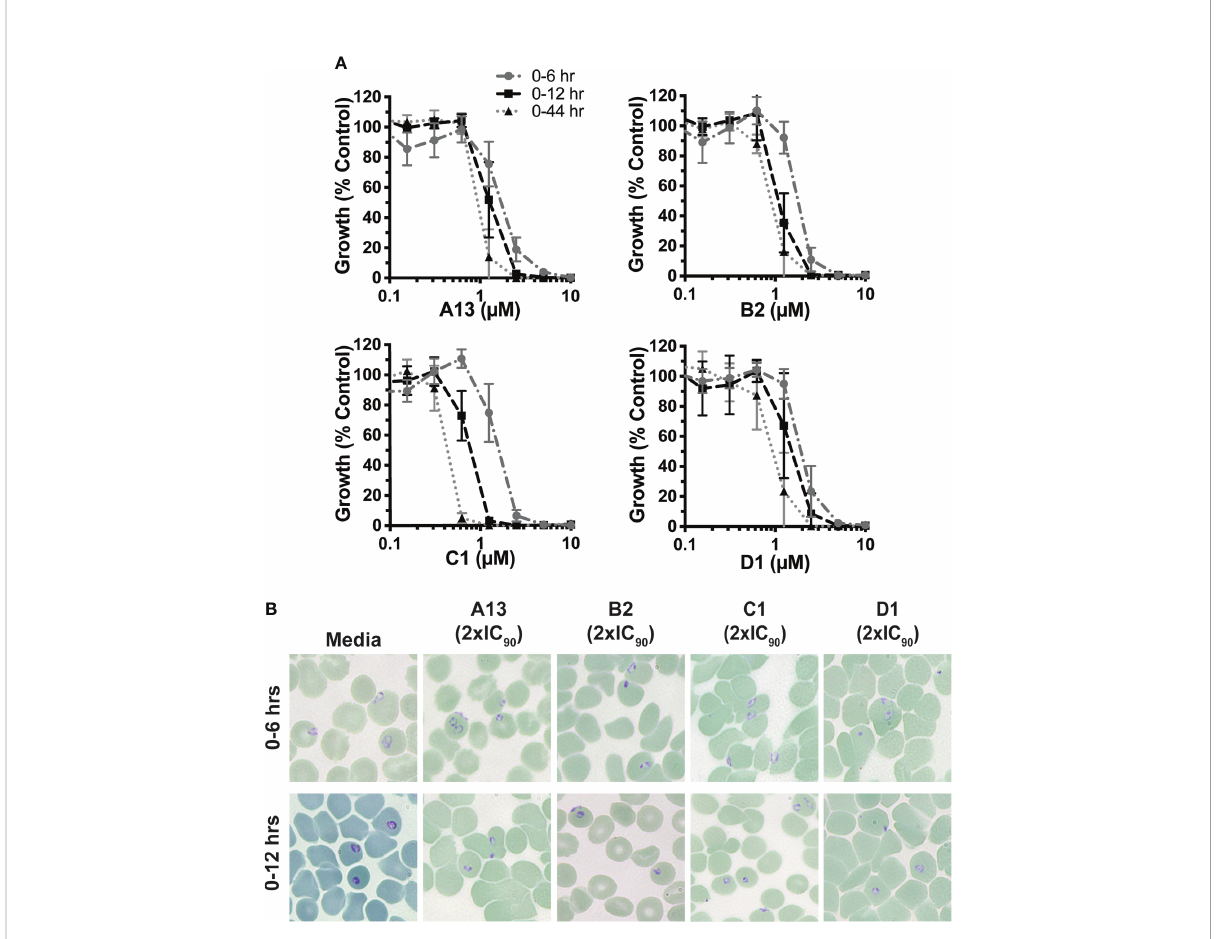
FIGURE 2 Growth inhibition pro fi les of azithromycin analogues with short term treatment (A) Growth inhibition pro fi le of A13, B2, C1 and D1 with very early ring-stage treatment across 0-6 hrs and 0-12 hrs post-invasion compared to a full in-cycle treatment. Early ring-stage P. falciparum (D10- PfPHG) parasites (<4 hrs post-invasion) were treated with doubling dilutions of azithromycin analogues for 0-6 hrs or 0-12 hrs prior to washing the drug out, with cultures allowed to continue growing until parasites were 44 hrs old. A 0-44 hrs control where parasites were maintained on drug was also included. There were signi fi cant differences between all 0-6 hrs vs 0-44 hr treatments of A13, B2, C1 and D1 (A13 and B2 P=0.01; C1 and <0.0001). A signi fi cant difference was also observed for 0-6 hrs vs 0-12 hrs of A13, B2 and C1(A13 P=0.01; C1 and B2 P=<0.0001) but not D1 (P=NS). Signi fi cant difference was observed for 0-12 hrs vs 0-44 hrs for C1 and D1 (P= 0.01), but not A13 or B2 (P=NS). Parasitemia was measured via fl ow cytometry 44 hrs post-invasion. Data represents the means of 3 or more experiments expressed as a percentage of non- inhibitory control and error bars represent SEM. (B) Representative Giemsa stained thin blood smears showing the growth phenotypes seen for non-inhibitory media controls, azithromycin analogues A13, B2, C1 and D1 (2 x IC 90 ) 0-6 hrs post treatment (top panels) and 0-12 hrs post treatment (bottom panel). Data for parallel azithromycin and dihydroartemisinin treatments are available in (Burns et al.,